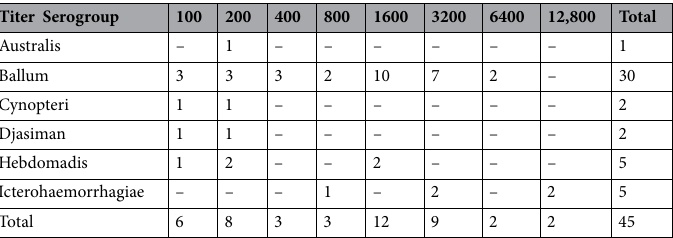
Table 2. Titers of rodent samples reactive with serogroups of Leptospira *. *Not included are those six samples most reactive to two different serogroups and as reported in Supplementary Table 3.